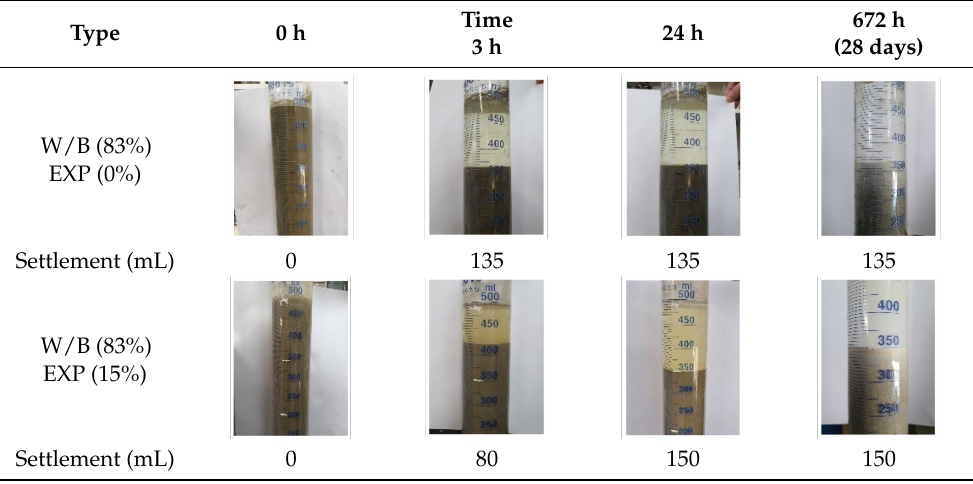
Table 3. Segregation